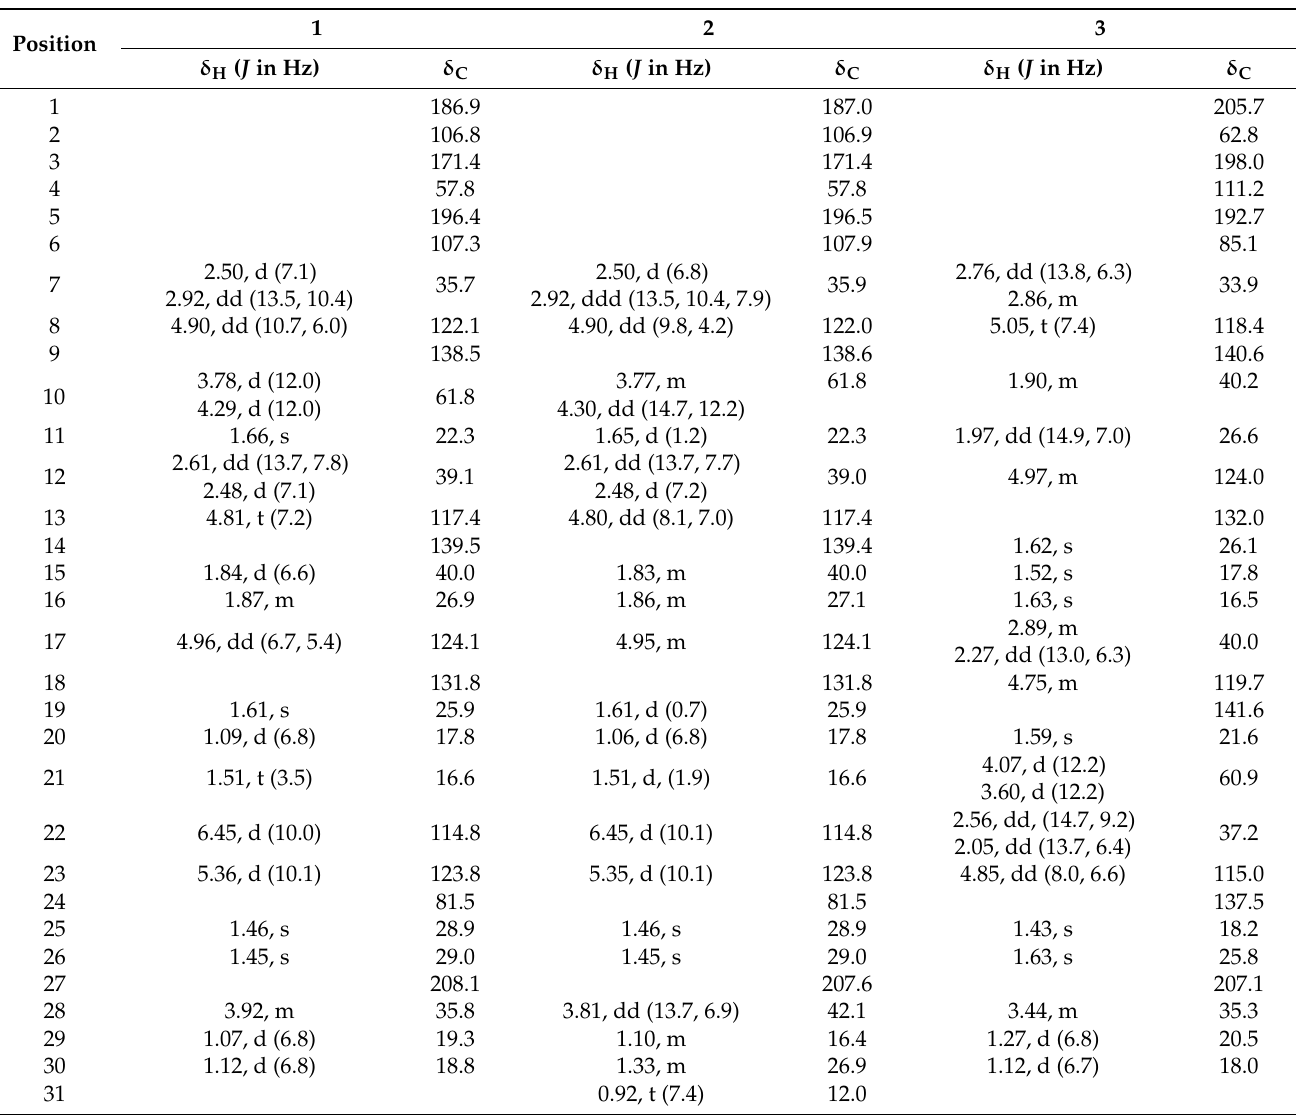
Table 3. 1 H and 13 C NMR data (CDCl 3 ) of compound 1 – 3